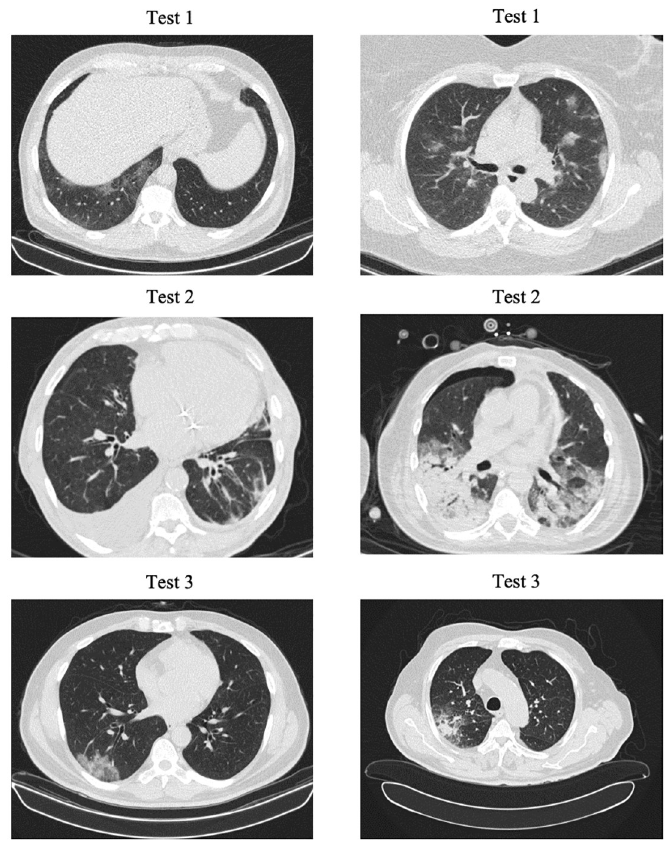
Fig 2. Sample CT slices from the first three test sets. In Test set 1, the noise level is high. In Test 2, some cases reveal cardiovascular-related complications. In Test 3, the image quality and contrast are higher compared to other test sets.